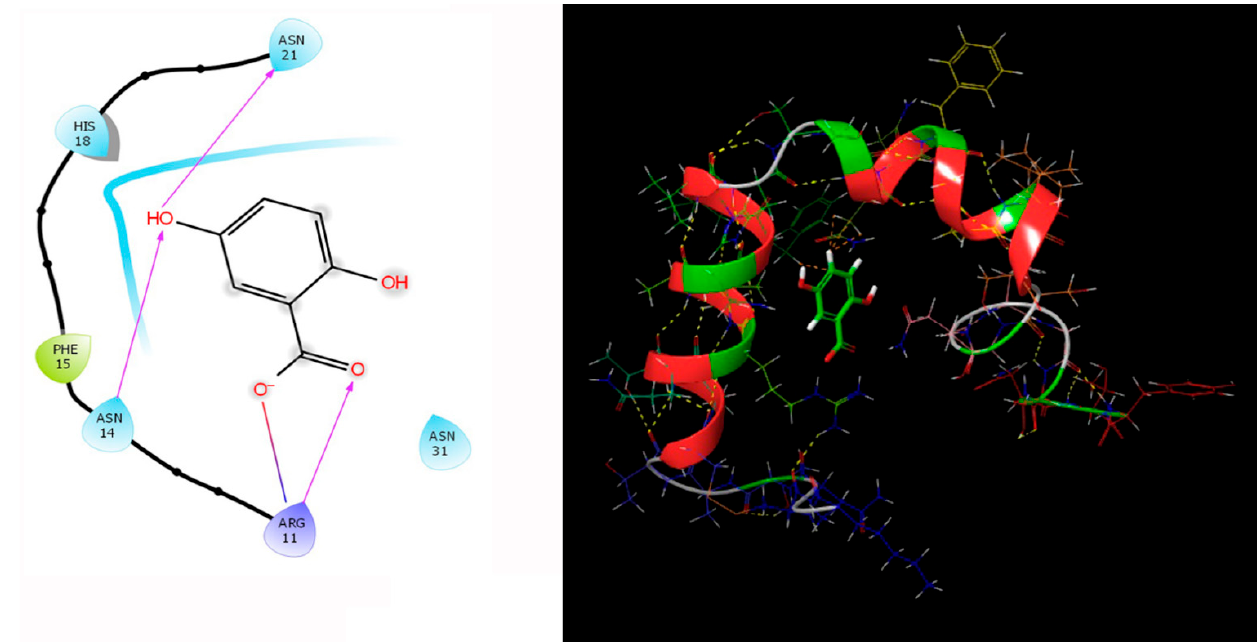
Figure 3. Human amylin’s interaction (2L86) with gentisic acid.